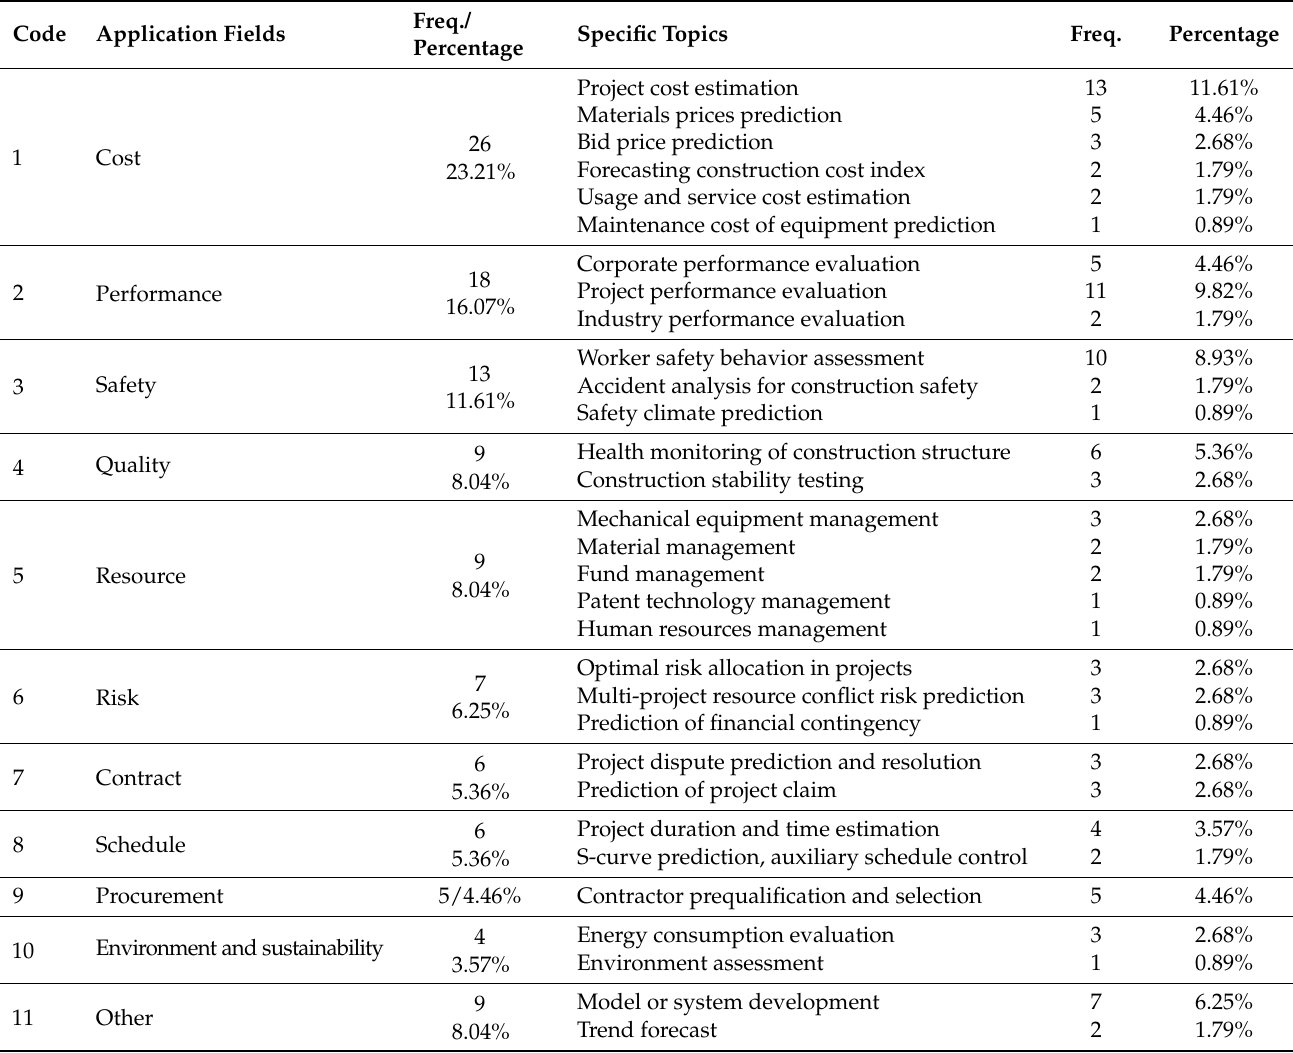
Table 4. 11 application fields and 31 specific topics on ANN in